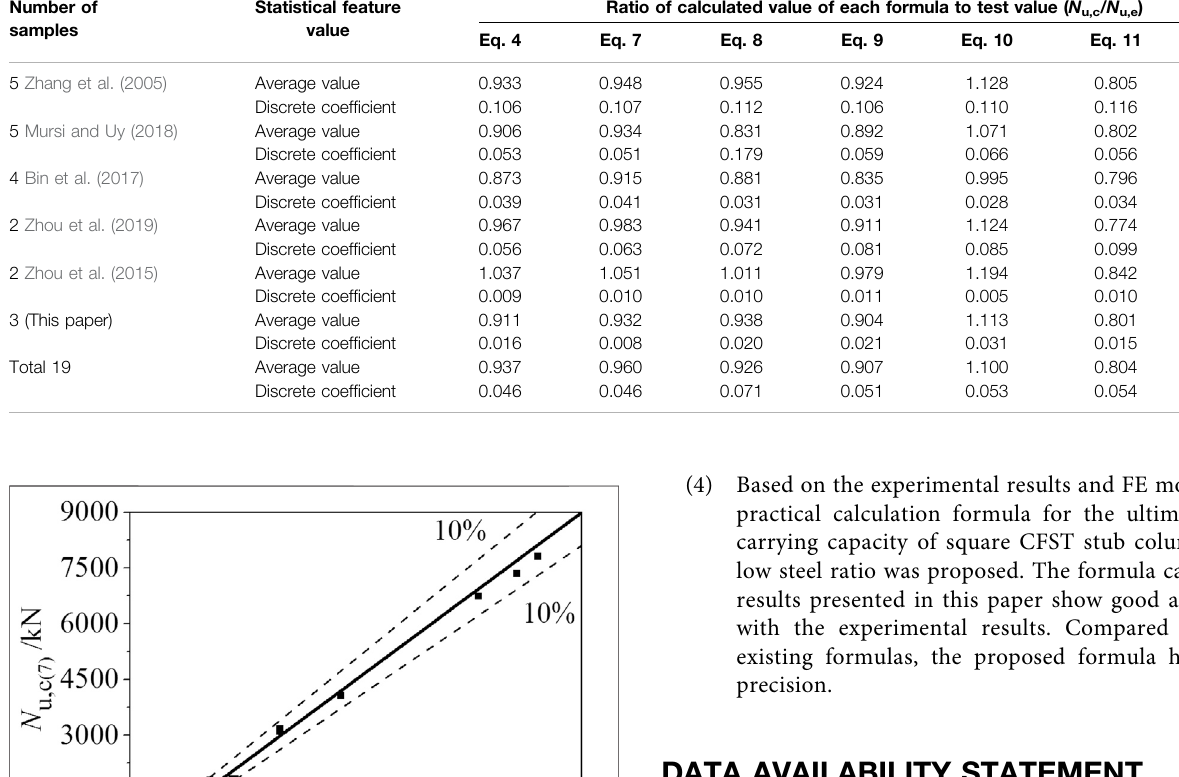
TABLE 5 | Comparison of calculation results and experimental results. Number of samples